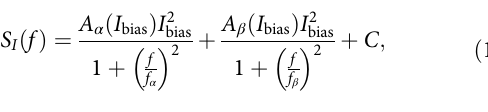
areal density of V S defects in our sample, ( N T ) 2/3 = (4 ± 1) × 10 11 − 2 cm (ref. 13 ), and a tunneling electron velocity known to be ν = cross-section values to be of the order σ ð 0 Þ α (cid:4) 10 (cid:3) 24 (cid:3) 10 (cid:3) 23 cm 2 ð 0 Þ (cid:4) 10 (cid:3) 21 (cid:3) 10 (cid:3) 20 cm 2 . The observation that σ ð 0 Þ and σ β